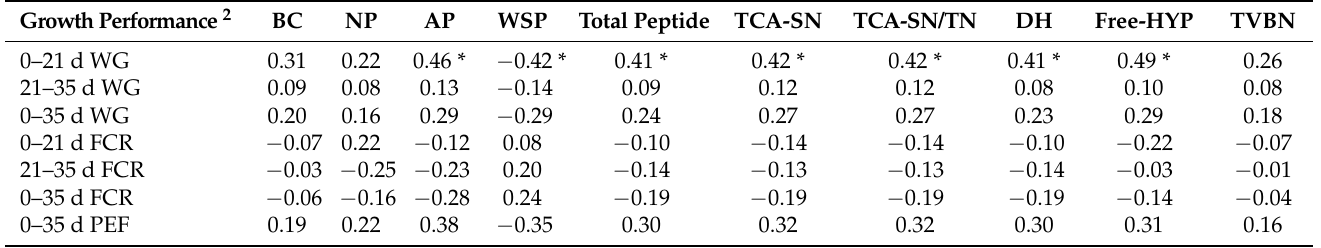
Table 8. Correlations between physicochemical characteristics of FMSMPs and growth performance of broilers 1 .